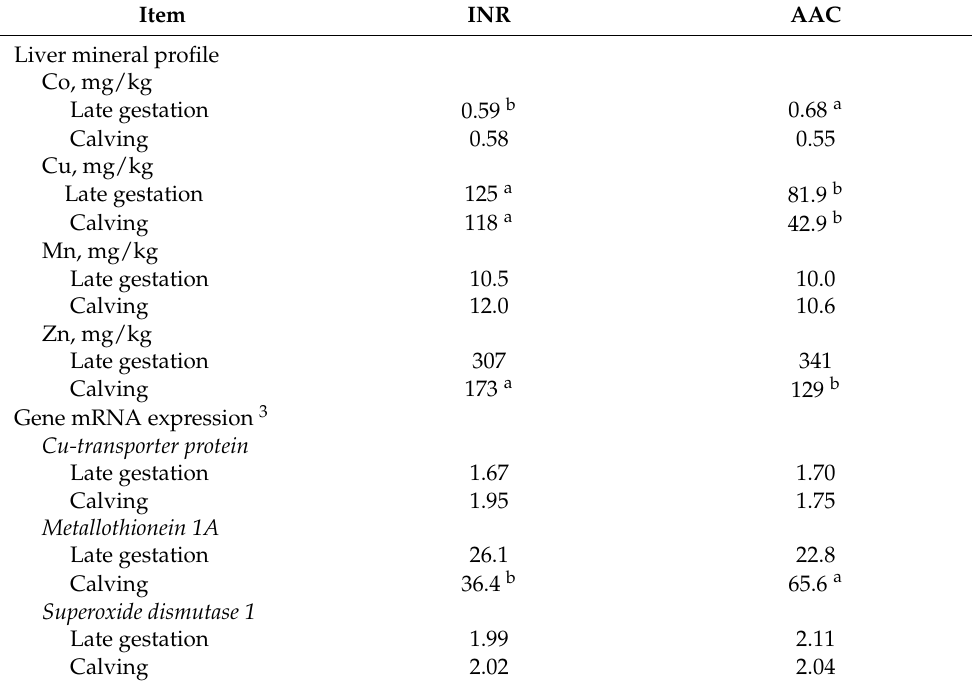
Table 2. Concentrations of Co, Cu, Mn, and Zn and expression of genes in the liver in beef cows that received diets containing supplemental sulfate sources of Co, Cu, Mn, and Zn (INR) or organic- complexed source of Co, Cu, Mn, and Zn (AAC) during gestation 1,2 . Item INR AAC Liver mineral profile Co,